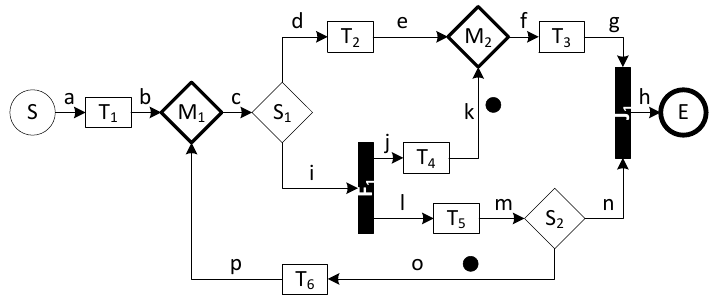
Figure 8. The example workflow graph in state h k, o i